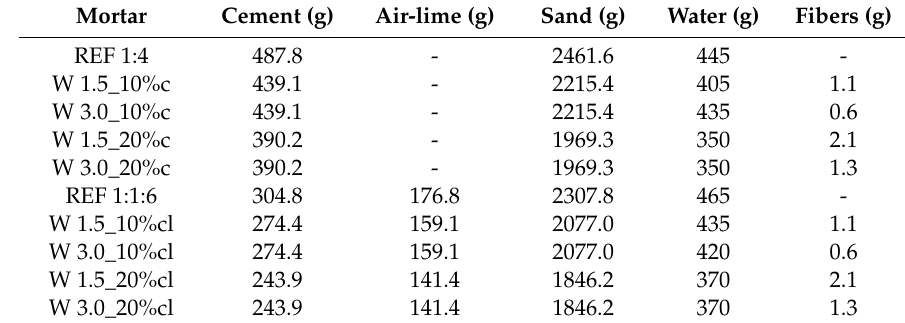
Table 2. Composition of the mortar mixes by mass.